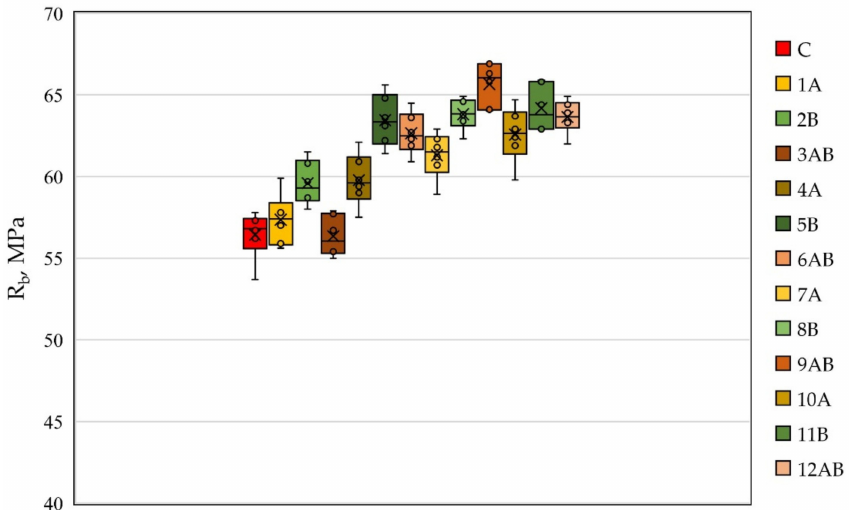
Figure 1. The compressive strength of fiber cement specimens depending on the type of dispersed reinforcement.